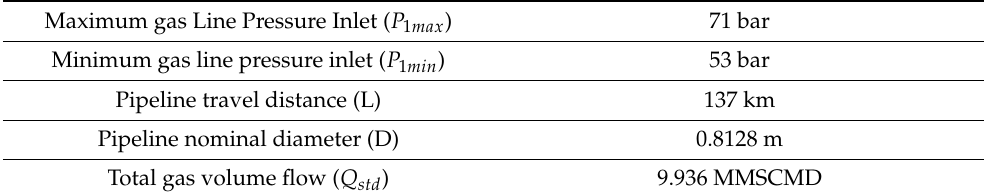
Table 2. Real field data for Al-Alamein gas extension